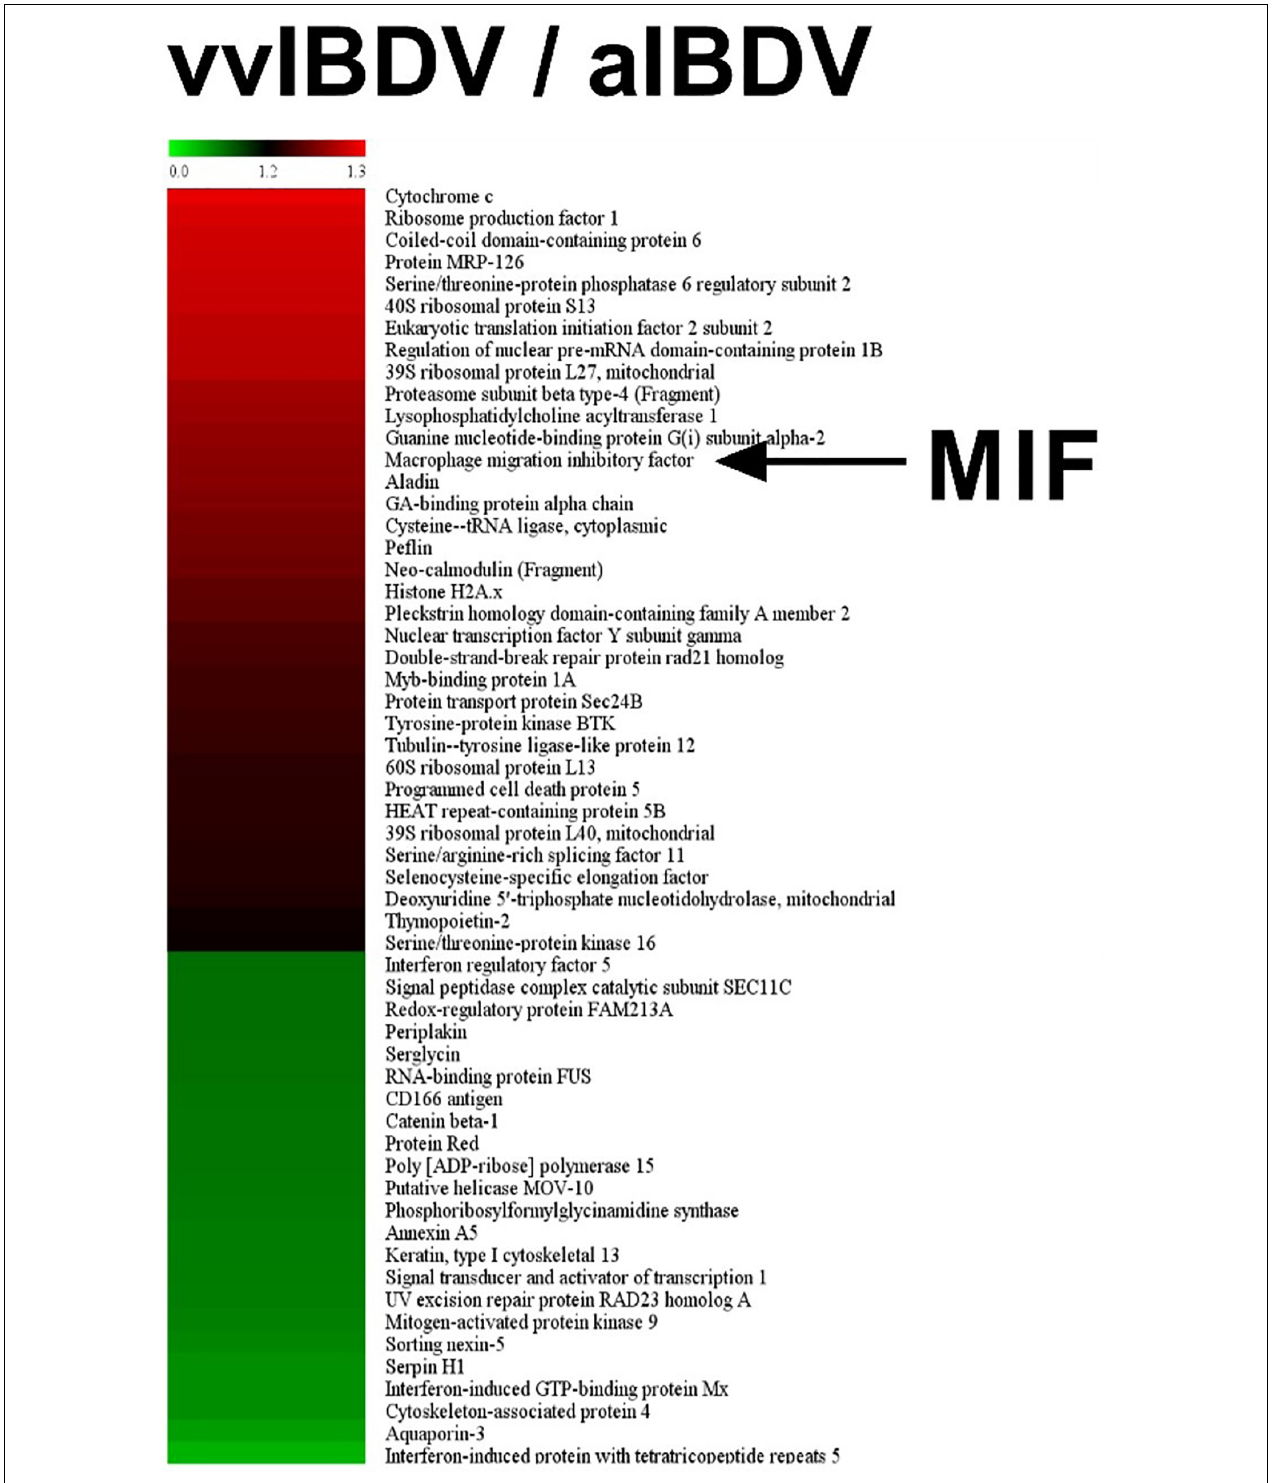
FIGURE 2 | iTRAQ LC-MS/MS was conducted on very virulent infectious bursal disease virus (vvIBDV)- and attenuated IBDV (aIBDV)-infected B lymphocyte samples at 36 h.p.i. The expression level of proinflammatory factor macrophage migration inhibitory factor (MIF) was found to be higher in the vvIBDV-infected group than in the aIBDV-infected group